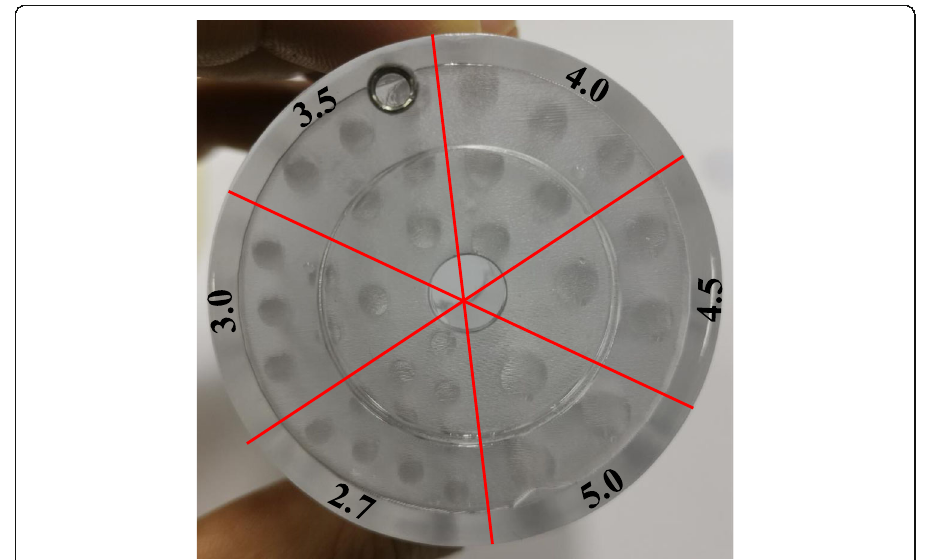
Fig. 4 The Derenzo resolution phantom with rod diameters (in mm)